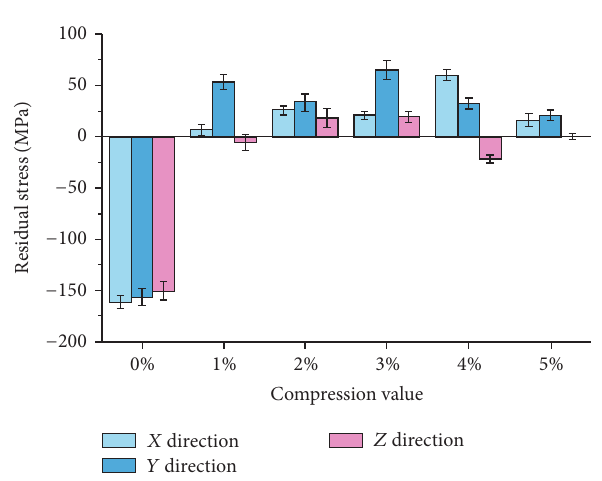
Figure 8: The error for measurement data. Table 4: Residual stress of quenched and compressed